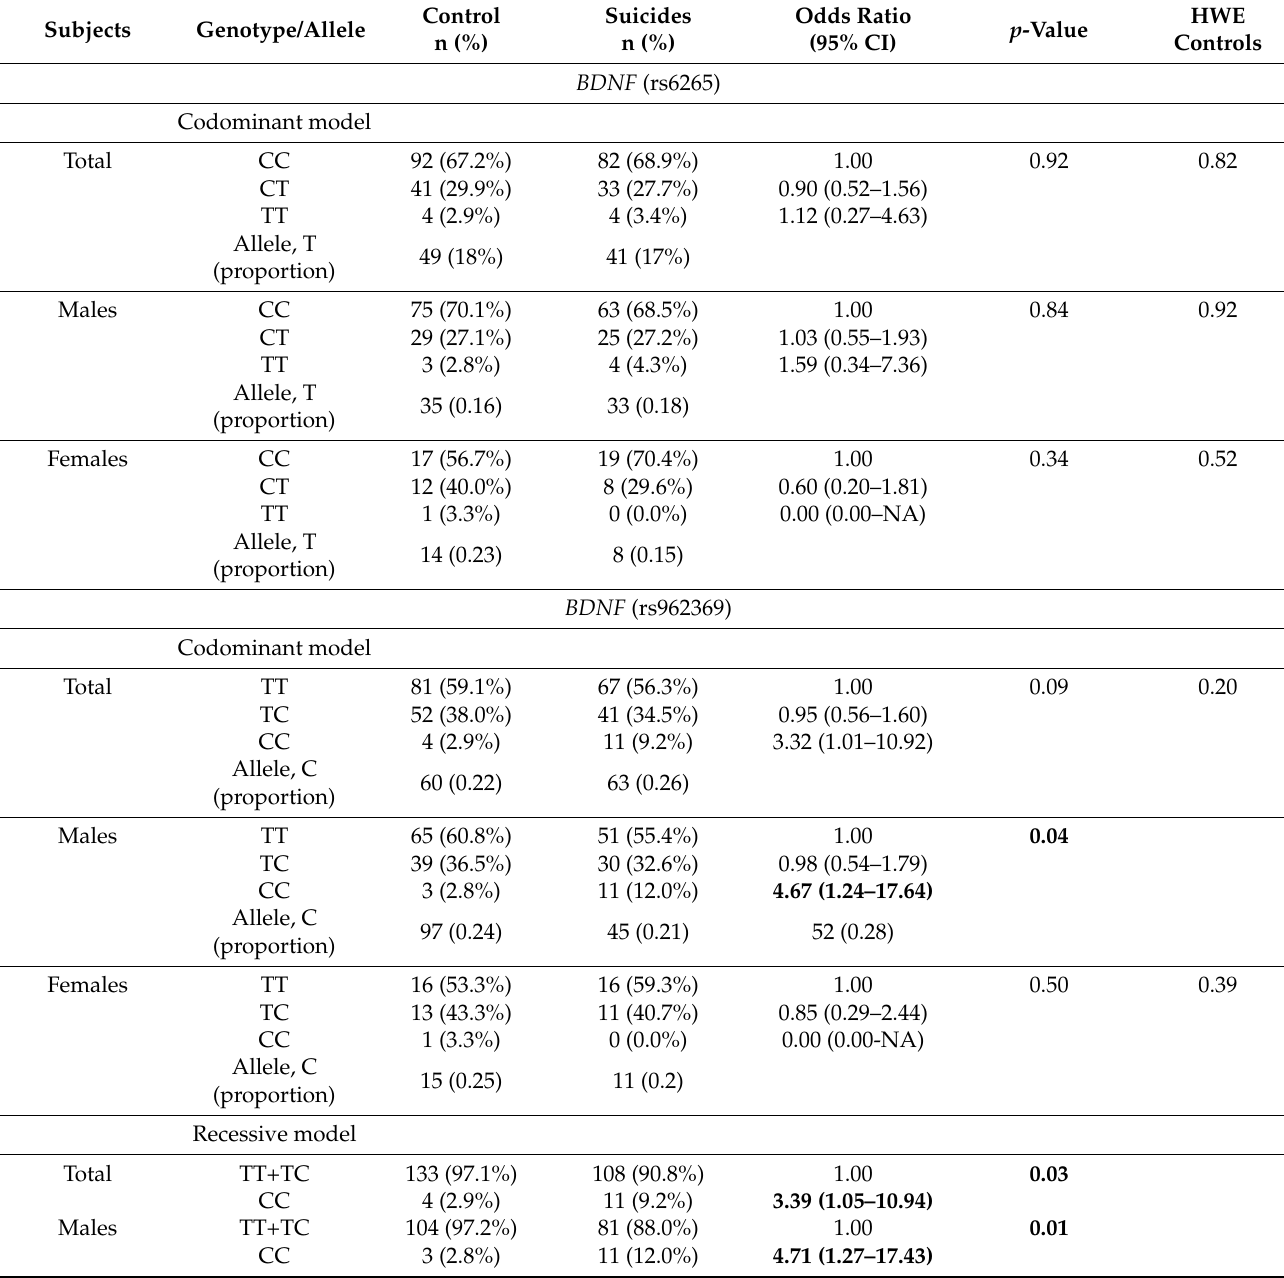
Table 5. Distribution of genotypes and analysis of the association between BDNF (rs6265) and BDNF (rs962369) gene variants and suicide